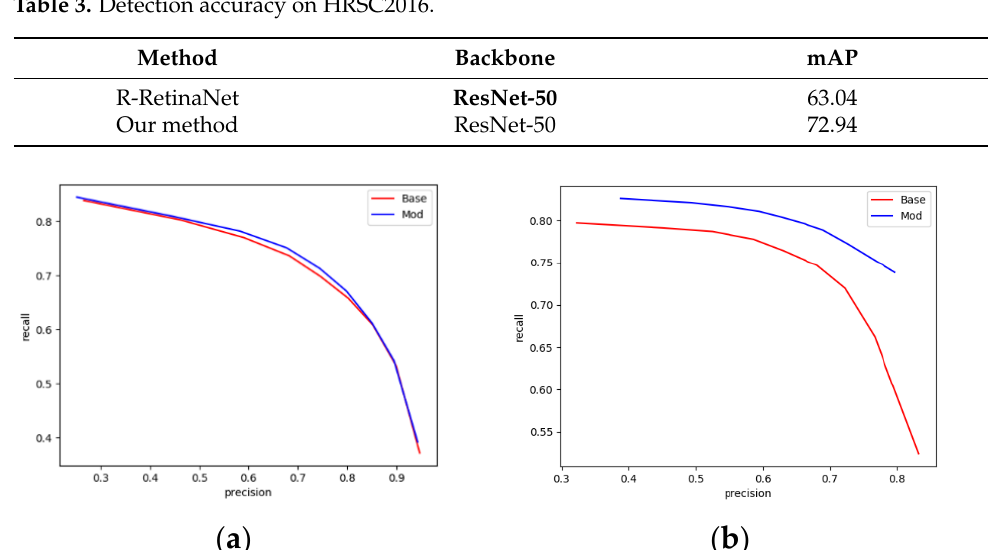
( b ) Figure 6. Recall rates of targets from different angles. The ordinate is different recall rates with the same accuracy. ( a ) DOTA. ( b ) HRSC. Our method can effectively improve the recall rate of the target when the target is different from the anchor. When the target angle is the same as that of the anchor, it is basically the same under the dataset, and it is still improved under the HRSC2016 dataset.